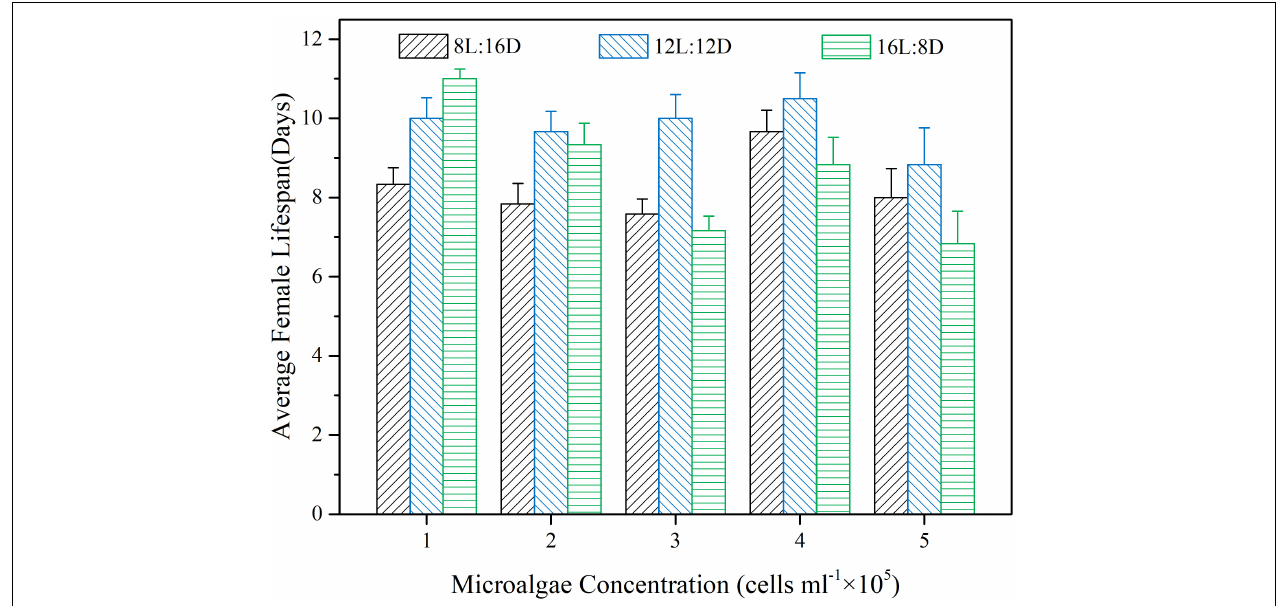
FIGURE 3 | Effects of different concentrations of the microalgal diet and photoperiods on female lifespan of B. amoyensis ( N = 12). Data is presented as mean ± SE. TABLE 1 | Final population size and intrinsic rate (r) of B. amoyensis cultured over a 12 days period fed on different microalgal diets under three photoperiod regimes. Photoperiod regime Microalgal Total number of final concentration population – All (cells mL − 1 )